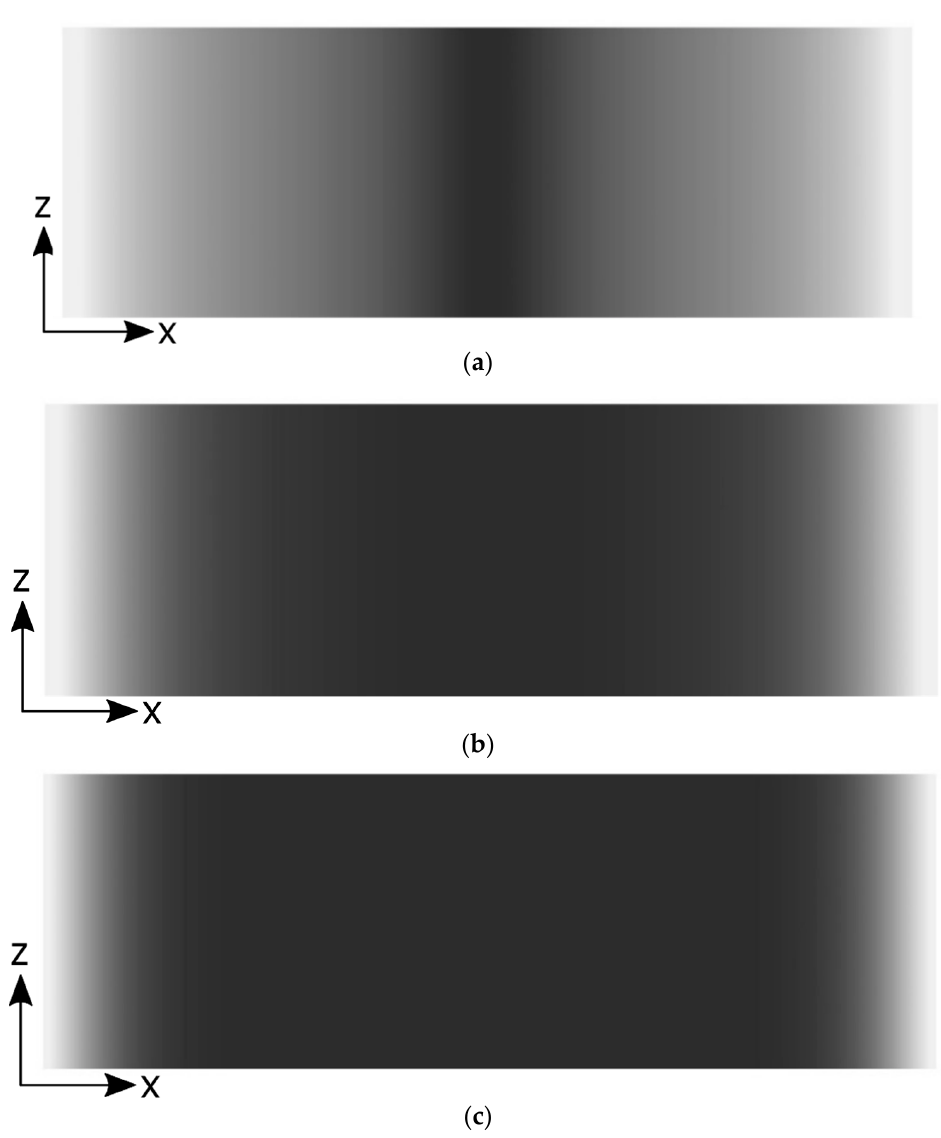
Figure 6. The optical light intensity represents the bulk orientation in Figure 5. The change in grayscale intensity represents the birefringence variation, which provides the alignment information. ( a ) The case study with the parameters λ * = 103 and W = 10. ( b ) The case study with the parameters λ * = 103 and W = 40. ( c ) The case study with the parameters λ * = 103 and W = 200.